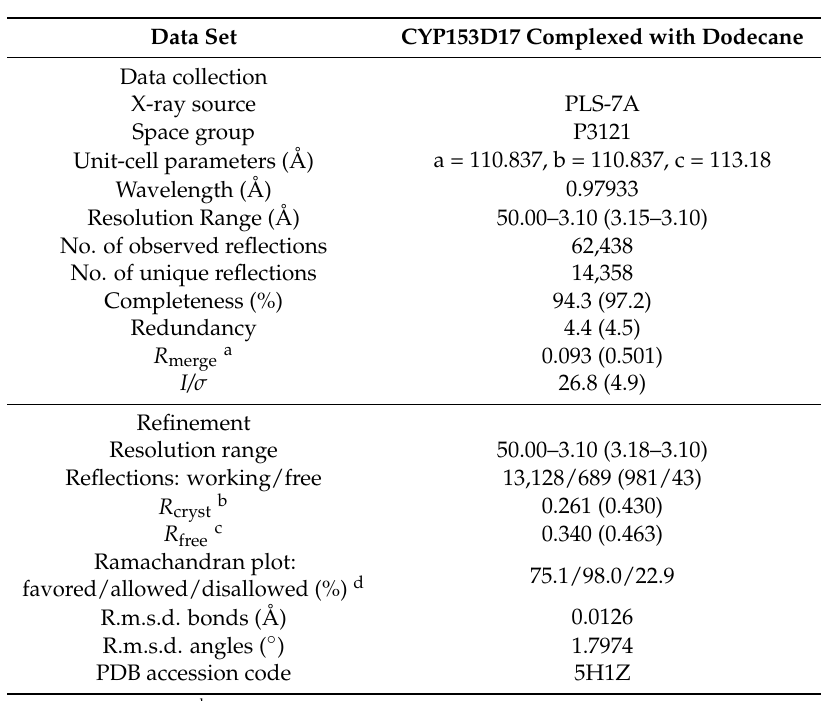
Table 2. X-ray data collection and refinement statistics.